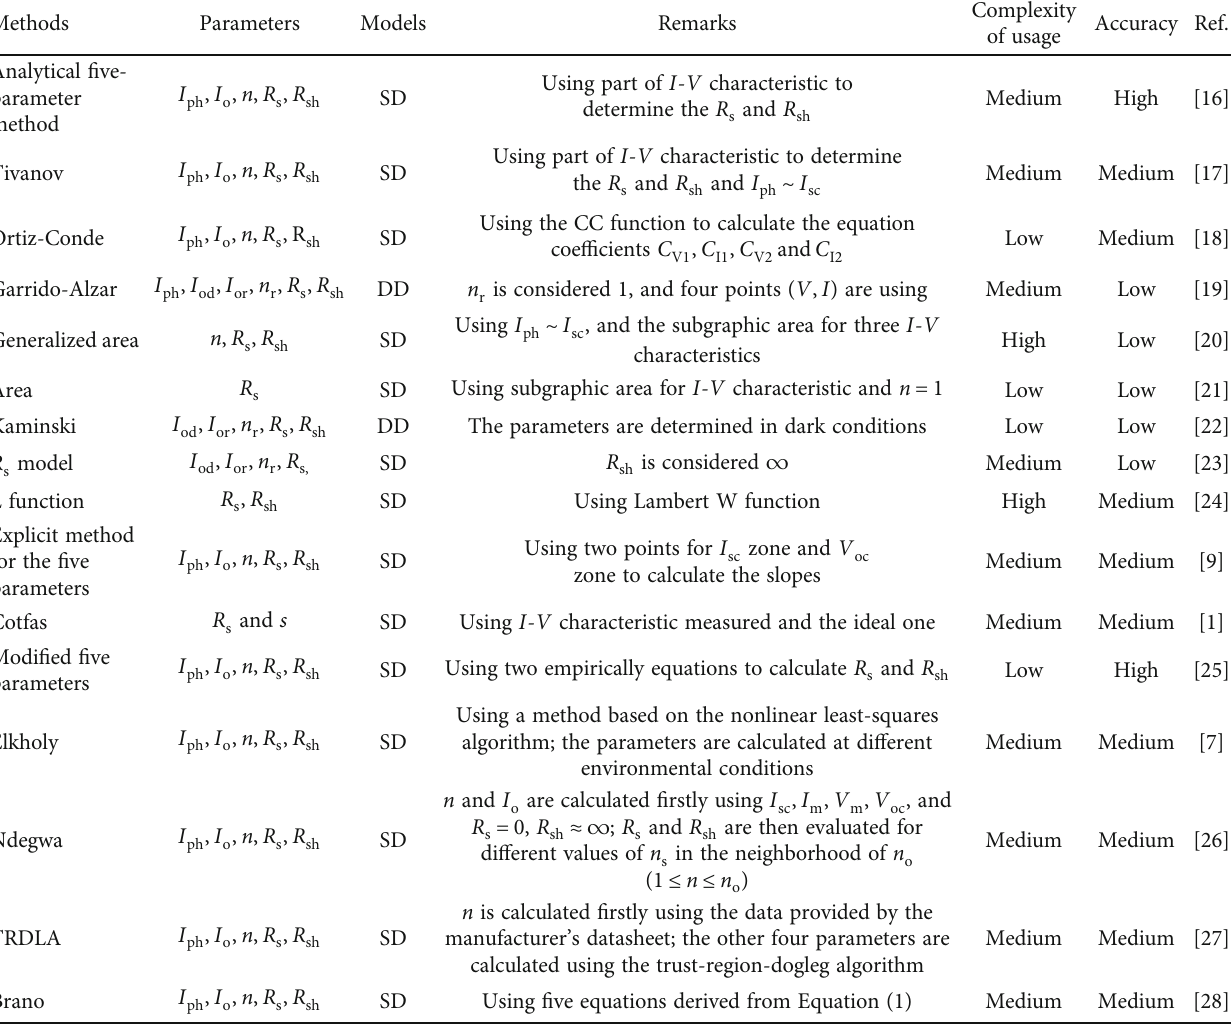
Table 1: The analytical